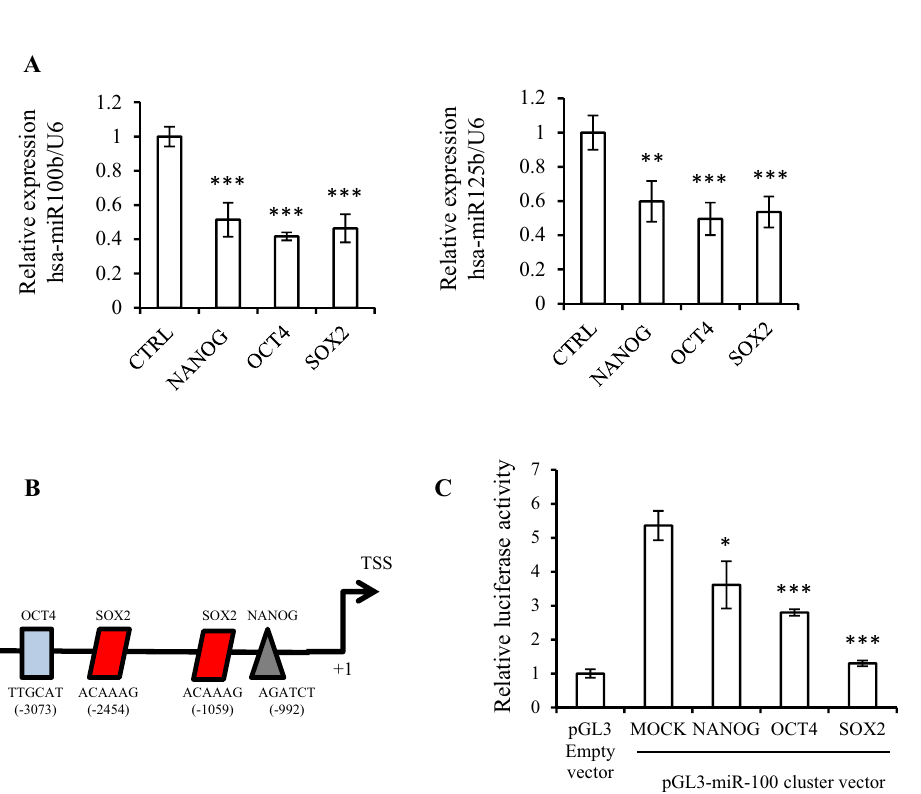
Figure 2. Stemness factors regulates miR-100 and -125b expression. ( A ) miR-100 and miR-125b expression levels measured after transfection of NANOG, OCT4, and SOX2 with the TaqMan probe. Relative expression was calculated using U6 expression as an internal control. ( B ) Physical map of the hsa-miR-100 promoter region for the design of chromatin immunoprecipitation (ChIP) primer. The position of the stemness binding motif designed ChIP primer. ( C ) Stemness factor transcriptional activity was assessed by pGL3-miR-100 promoter luciferase reporter in Hep3B cells. The average (column) ± SD (bar) is indicated ( * p < 0.05, ** p < 0.01, *** p <